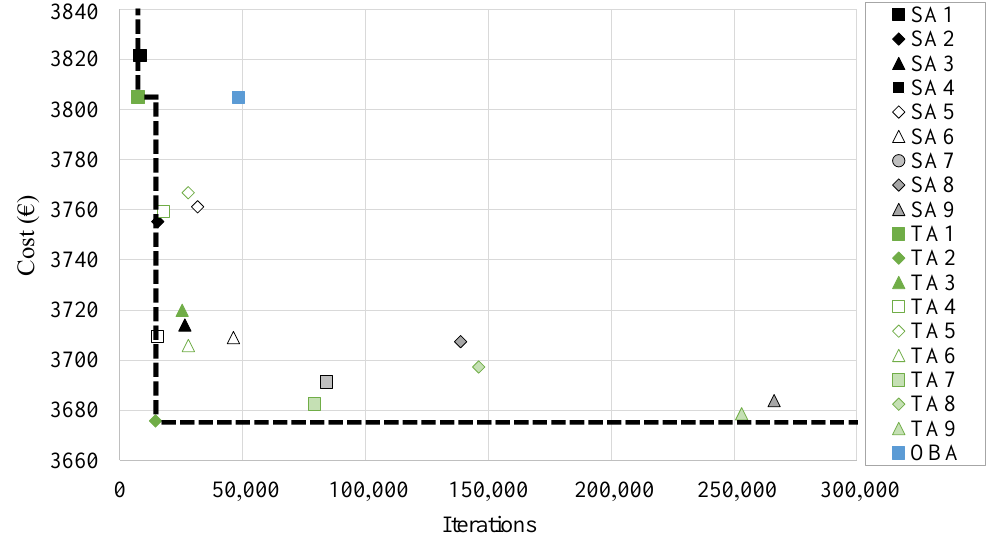
Figure 11. Pareto’s front of the results obtained by the three metaheuristic techniques. The optimal RCPHF obtained by applying the metaheuristic algorithms present several common characteristics. In this context, Table 6 contains the value of each of the different design variables of the optimal frames. It can be noted that the set of optimal RCPHF is characterized by slender sections of reduced depth with a dense passive reinforcement distribution. With reinforcement densities of 91 kg/m 3 in the case of the SA algorithm result, 89.12 kg/m 3 for the TA and 86.01 kg/m 3 in the case of the OBA. Some optimal designs present localized reductions in shear reinforcement, a lack solved by local increases in flexural reinforcement. The passive reinforcement density of the OBA algorithm result is slightly lower than those obtained by applying the rest of the considered metaheuristics. This reduction in the general passive reinforcement of the RCPHF is solved by increasing the upper slab and lateral wall depth. This results in using 6.75% and 5.68% more concrete when compared to the optimal RCPHF obtained by the SA and TA algorithms, respectively. Table 6. Characteristics of the optimum RCPHF obtained by each metaheuristic